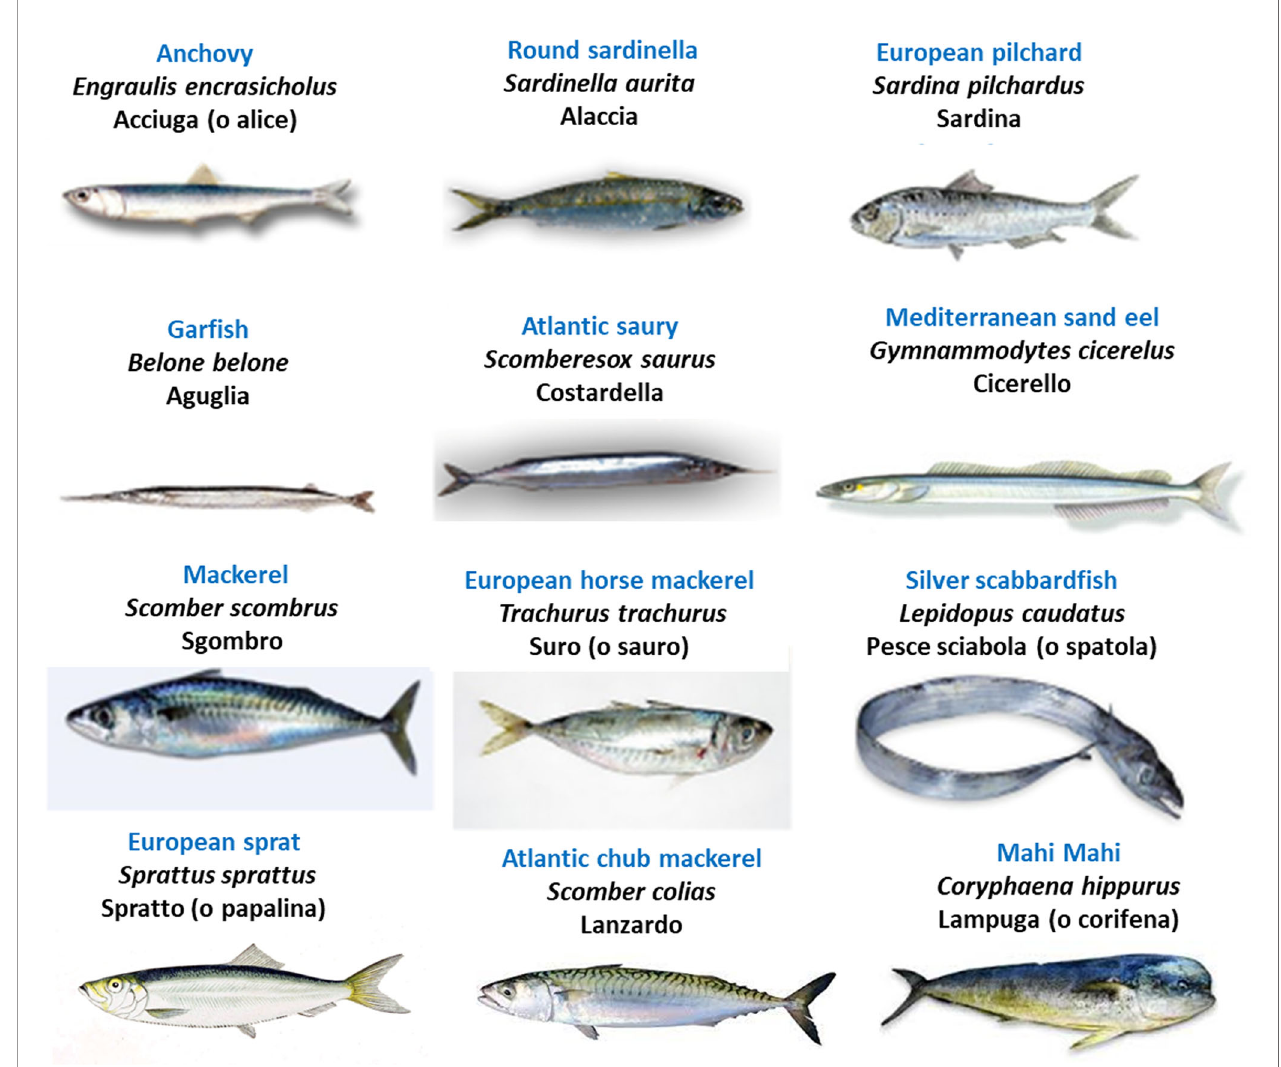
FIGURE 2 | Illustration of oily fi sh ( “ pesce azzurro ” [ “ azure fi sh ” ] in Italy), with the English names typed in blue, Italian in black, and scienti fi c/Latin name in italics . Source: